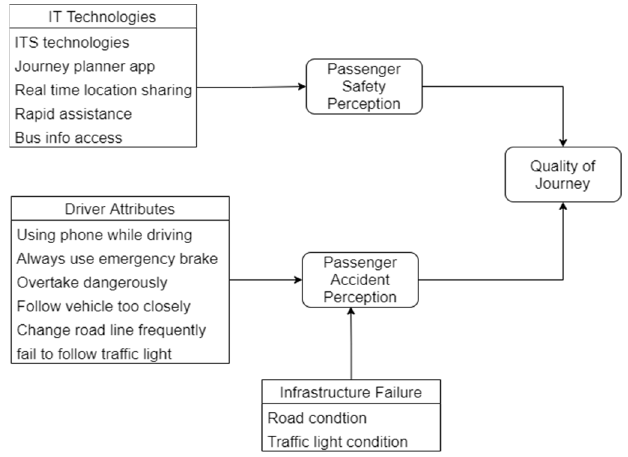
Figure 2. Conceptual frameworks for passenger safety and accident perception [30].